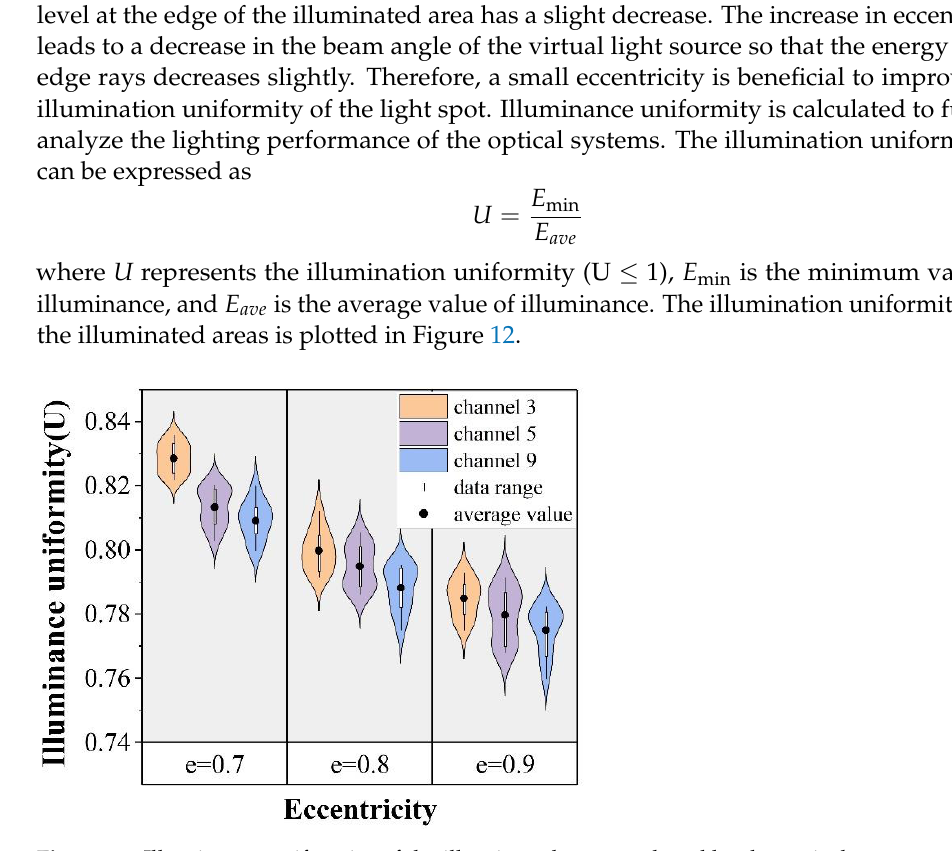
Figure 12. Illuminance uniformity of the illuminated area produced by the optical systems.